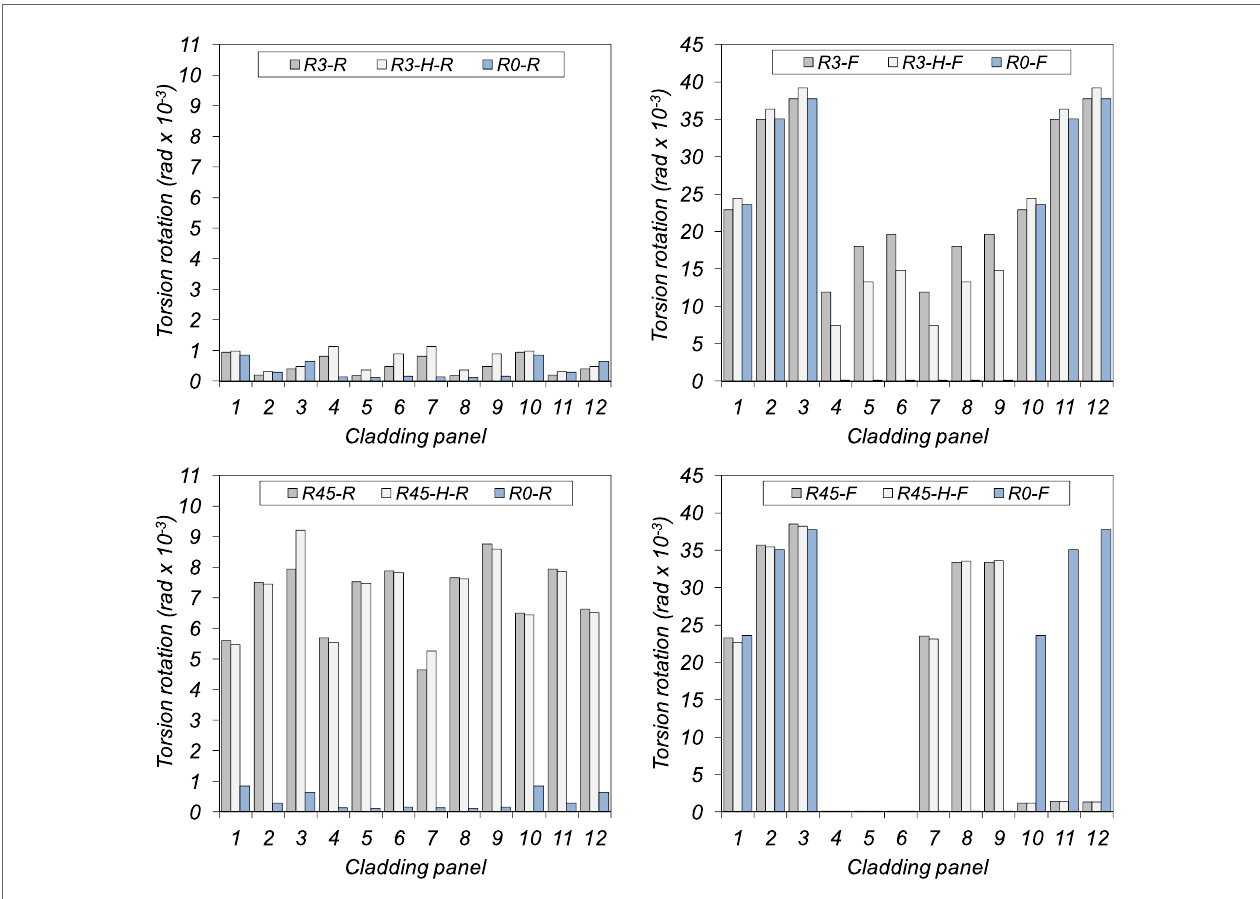
FigUre 14 | Torsion rotation demand in the cladding panels. The cladding panel number refers to Figure 11a